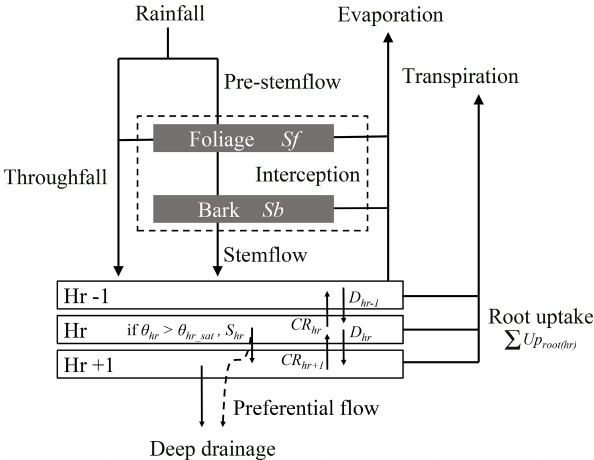
Figure 1. Schematic representation of the water fluxes and pools in the water balance module. Rainfall is divided into throughfall directly reaching the forest floor and a pre-stemflow component in- tercepted by the foliage and the bark. Once the foliage and bark are saturated, the water surplus increases the throughfall flux and flows along the branches and the trunk to generate stemflow. The through- fall and stemflow fluxes enter in the upper part of the soil and then, move from one horizon to the other according to the Darcy’s law. For a soil horizon, hr, the water input fluxes can be the drainage from the upper horizon ( D hr − 1 ) and the capillary rise from the lower horizon (CR hr + 1 ) that depend on the water potential gradient between the concerned horizons and on their hydraulic conductiv- ity. The output fluxes are the drainage ( D hr ) and the capillary rise (CR hr ), the root water uptake (UP root ( hr ) ), and the surplus ( S hr ) that appears when the horizon water content exceeds the saturated wa- ter content. One part of this last flux can directly leave the system as deep drainage (DD) when preferential flow is considered, in ad- dition to the water drainage of the last horizon. In parallel, water evaporates from foliage, bark and soil and is taken up by roots to enable tree transpiration. The evapotranspiration fluxes are all cal- culated with the Penman–Monteith